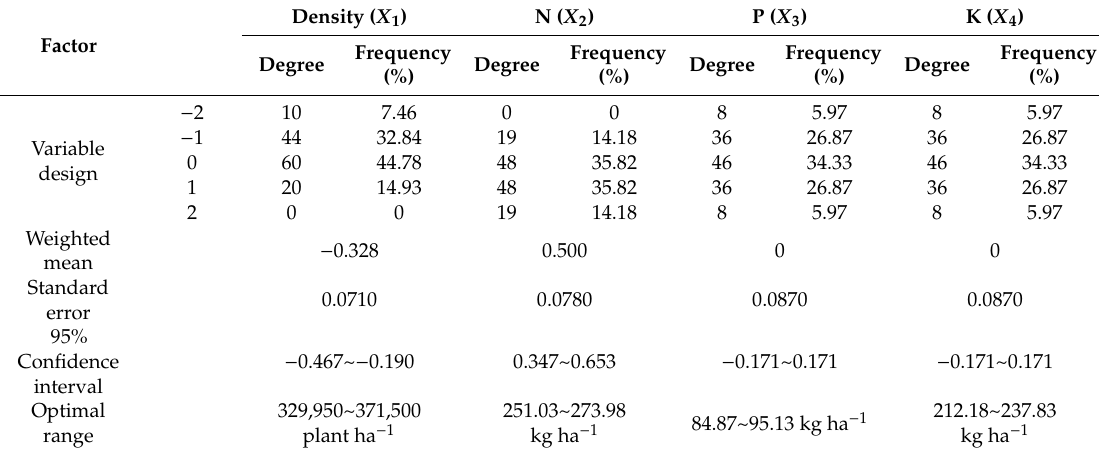
Table 4. Frequency of special X i value of hemp fiber yield beyond 2200 kg ha − 1